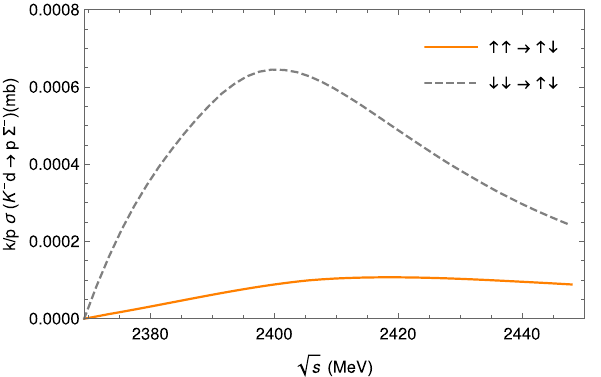
Fig. 5 Angular dependence of k as a function of cos θ (of the proton) for √ s th + 30 MeV (right) and